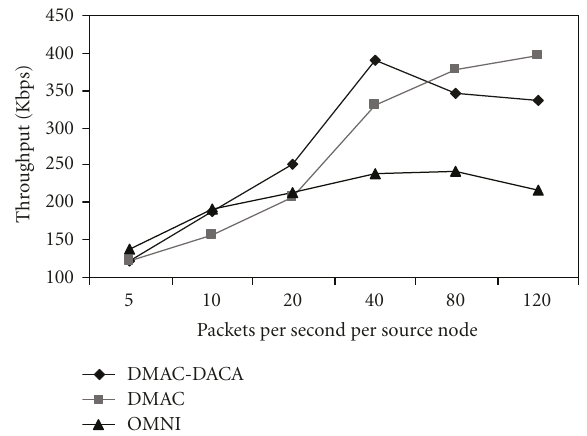
Figure 15: Throughput of OMNI IEEE 802.11, DMAC, and DMAC-DACA.